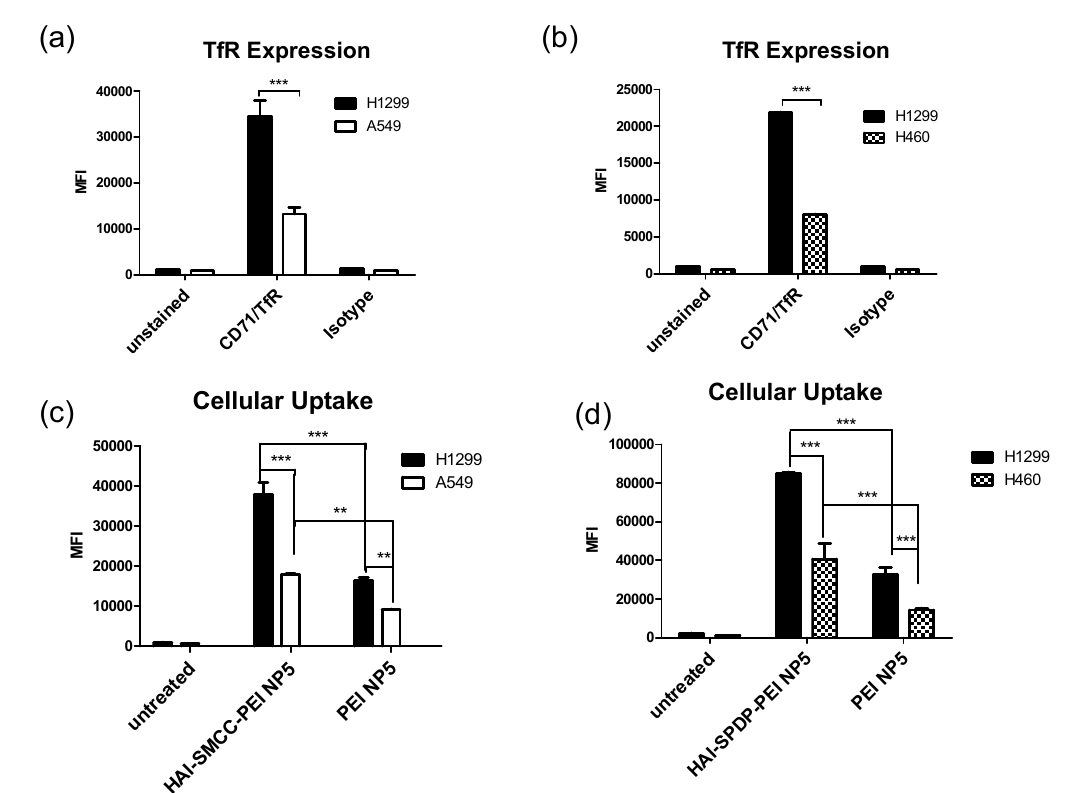
Figure 4. ( a ) H1299 and A549 cells were immunostained by the anti-CD71 antibody which binds to transferrin receptors (TfR) and by the isotype antibody which served as a control of non-specific binding. Median fluorescence intensity (MFIs) were quantified via flow cytometry; ( b ) H1299 and H460 cells were immunostained by the anti- CD71 antibody and by the isotype antibody (Data points indicate mean ± SD, n = 2. *** p < 0.001); ( c ) The cellular uptake of bPEI and HAI-SPDP-bPEI polyplexes was determined in TfR overexpressing cells H1299 and TfR low expressing cells A549. Polyplexes were prepared with 50 pmol of siRNA fluorescently labeled with Alexa Fluor 488 at N/P = 5 and transfected for 24 h. The MFIs were quantified by flow cytometry. (Data points indicate mean ± SD, n = 2. ** p < 0.01, *** p < 0.001); ( d ) The cellular uptake of bPEI and HAI-SPDP-bPEI polyplexes